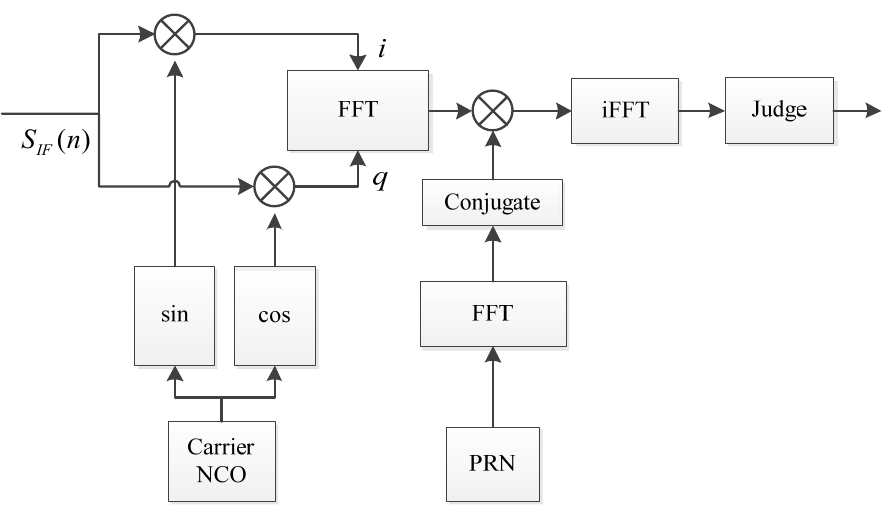
Figure 12. Schematic diagram of the acquisition process of the parallel code phase algorithm.